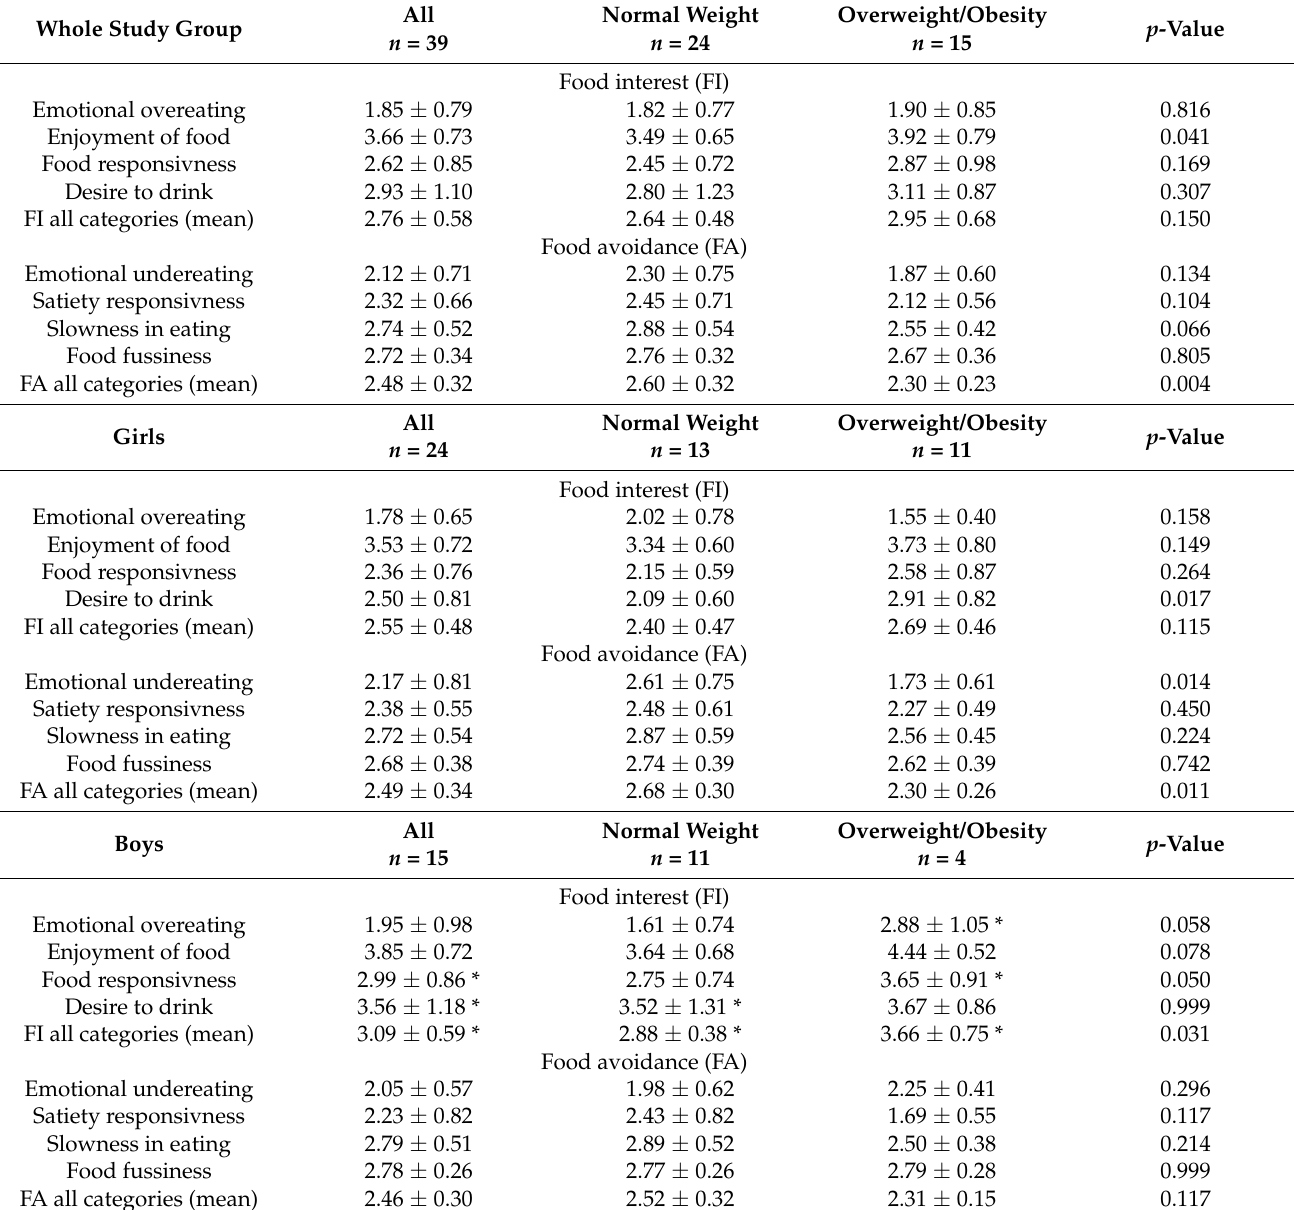
Table 4. The mean score of CEBQ depends on percentiles of body mass